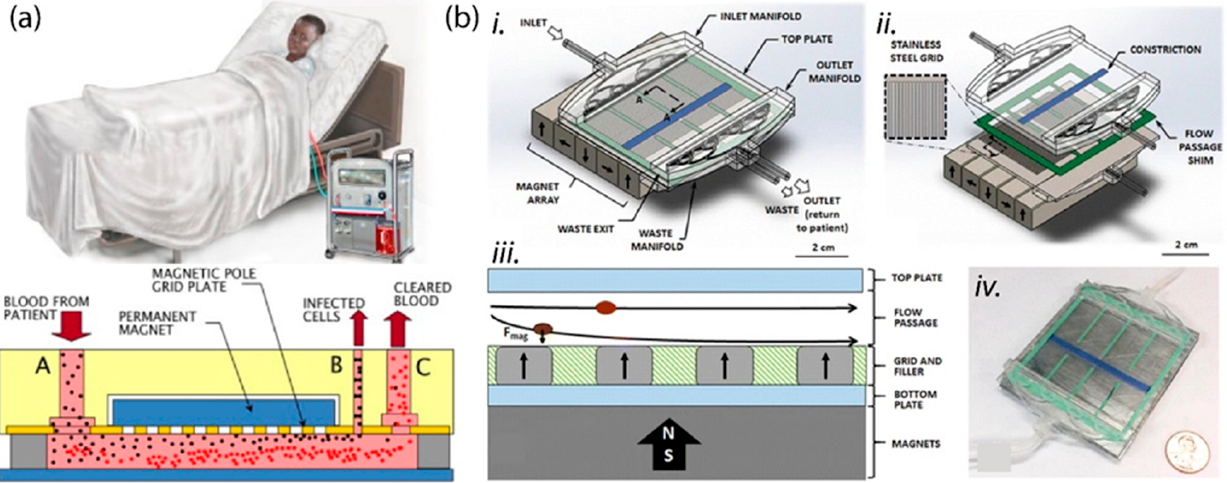
Figure 4. Magnetophoretic removal of malaria-infected red blood cells. ( a ) Conceptual design. Reproduced with permission [61]. Copyright 2012 Elsevier. ( b ) High-throughput microfluidic platform to separate malaria-infected RBCs. Reproduced with permission [62]. Copyright 2017 Springer Nature.